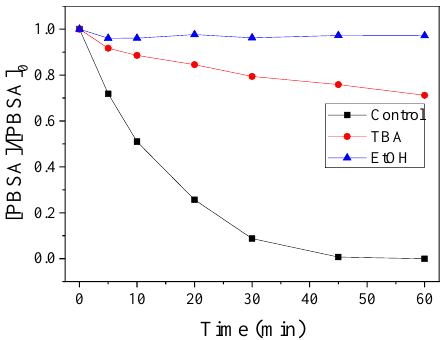
Figure 6. Total organic carbon (TOC) removal of the PBSA oxidized by the CoMn 2 O 4 -activated PMS system ( a ); Degradation of the PBSA using the recycled catalyst ( b ). Conditions: [PBSA] = 5 mg L −1 ; [catalyst] = 50 mg L −1 ; [PMS] = 250 mg L −1 ; T = 25 °C; and without pH adjustment.